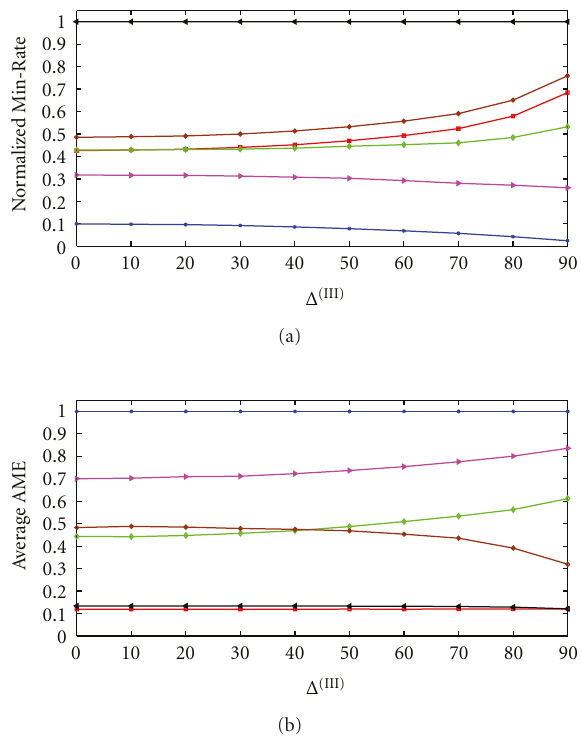
Figure 3: Experimental results for Model II: (a) Normalized Min- Rate versus Δ (II) ; (b) Average AME versus Δ (II) . Note that Δ (II) is not expressed in dB. The number of users ( K ), the number of runs ( N r ), and all graphical conventions are the same like in Figure 2.